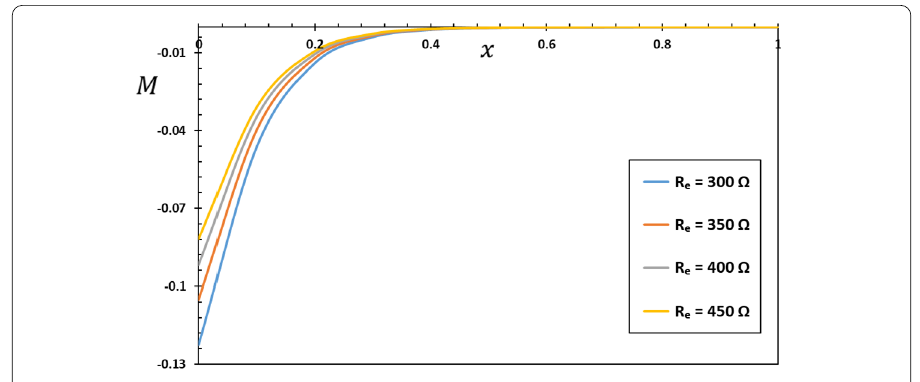
Figure 17 The effect of electric resistance Re on the variation of bending moment